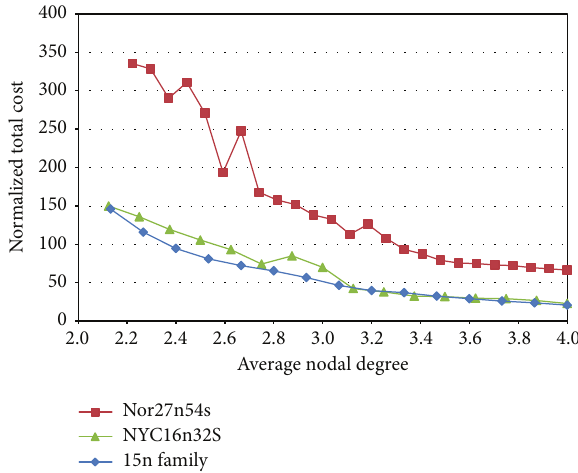
Figure 28: Normalized span restoration SCA costs for network families based on real network.